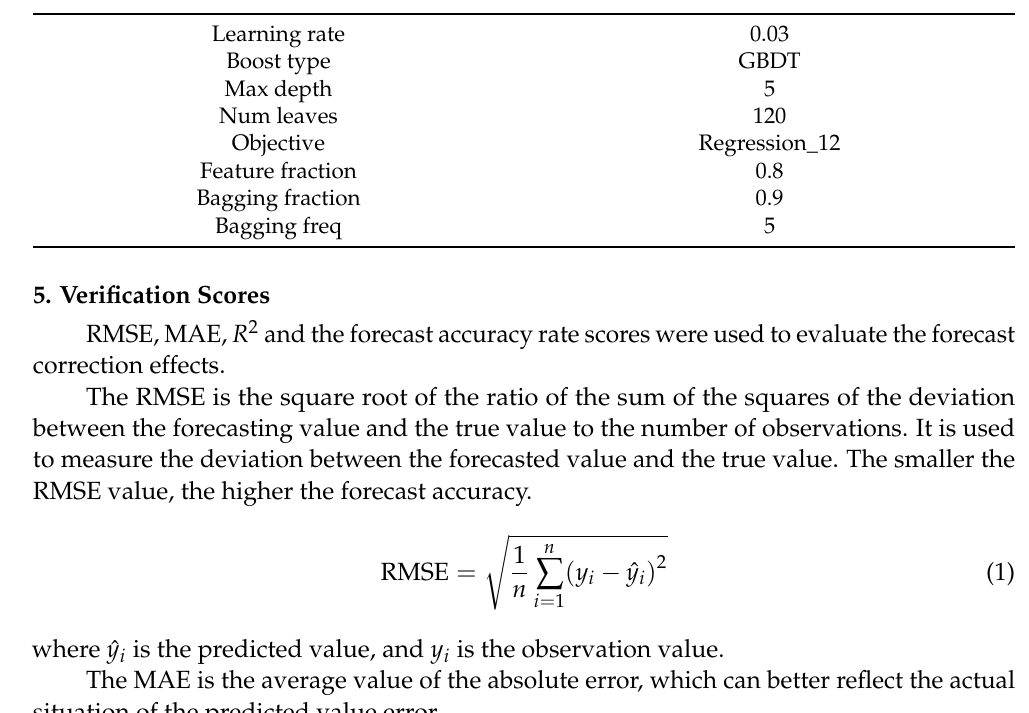
Table 1. LightGBM model core